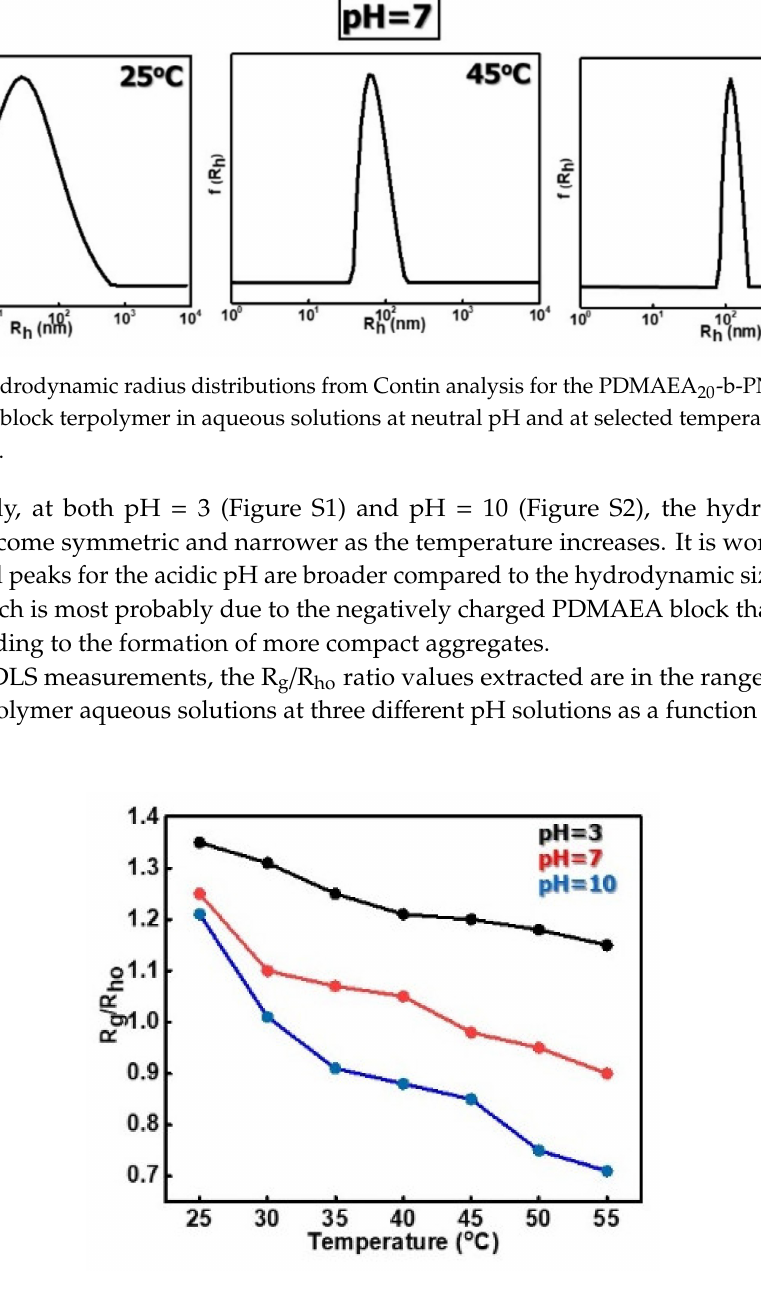
Figure 5. R g / R ho ratio values at acidic, neutral, and basic pH solution as a function of temperature for the PDMAEA 20 -b-PNIPAM 11 -b-POEGA 18 triblock